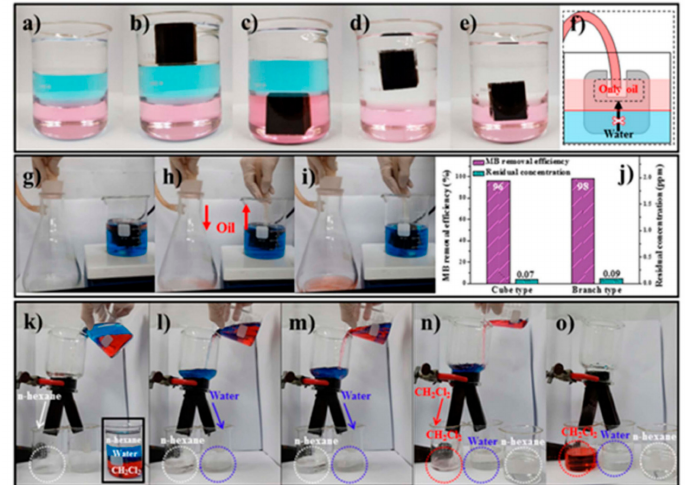
Figure 13. ( a ) Multiphase solutions containing 3 types of liquids such as n-hexane, water, and CCl 4 . The hydrophobic sponge stayed in the ( b ) n-hexane and ( c ) CCl 4 layers. The anti-overturn Janus sponges (AJSs) remained at the ( d ) n-hexane / water and ( e ) water / CCl 4 interfaces; ( f – i ) an AJS-based oil / water separation under artificial high waves; ( j ) removal e ffi ciency and residual concentration of MB adsorbed by cube and AJSs; ( k – o ) successive oil / water separation and aqueous pollutant purification by a pant-like AJS. Reproduced with permission from [220]. Copyright 2018 The Royal Society of